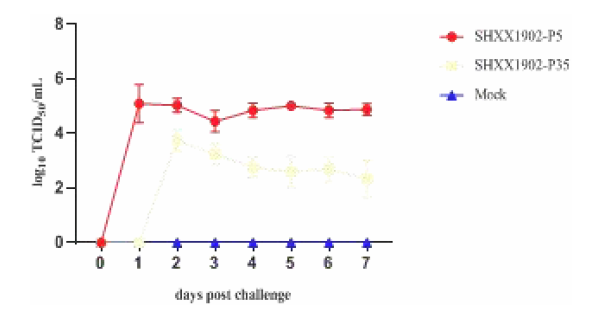
FIGURE 3 | Viral shedding in piglets inoculated with PEDV SHXX1902-P5, SHXX1902-P35, or mock inoculated. PEDV titers in rectal swab samples at each time point were determined with RT-qPCR. The viral titers (log10 TCID 50 /ml) are the mean viral titers of all the piglets in each group, and error bars represent SD.